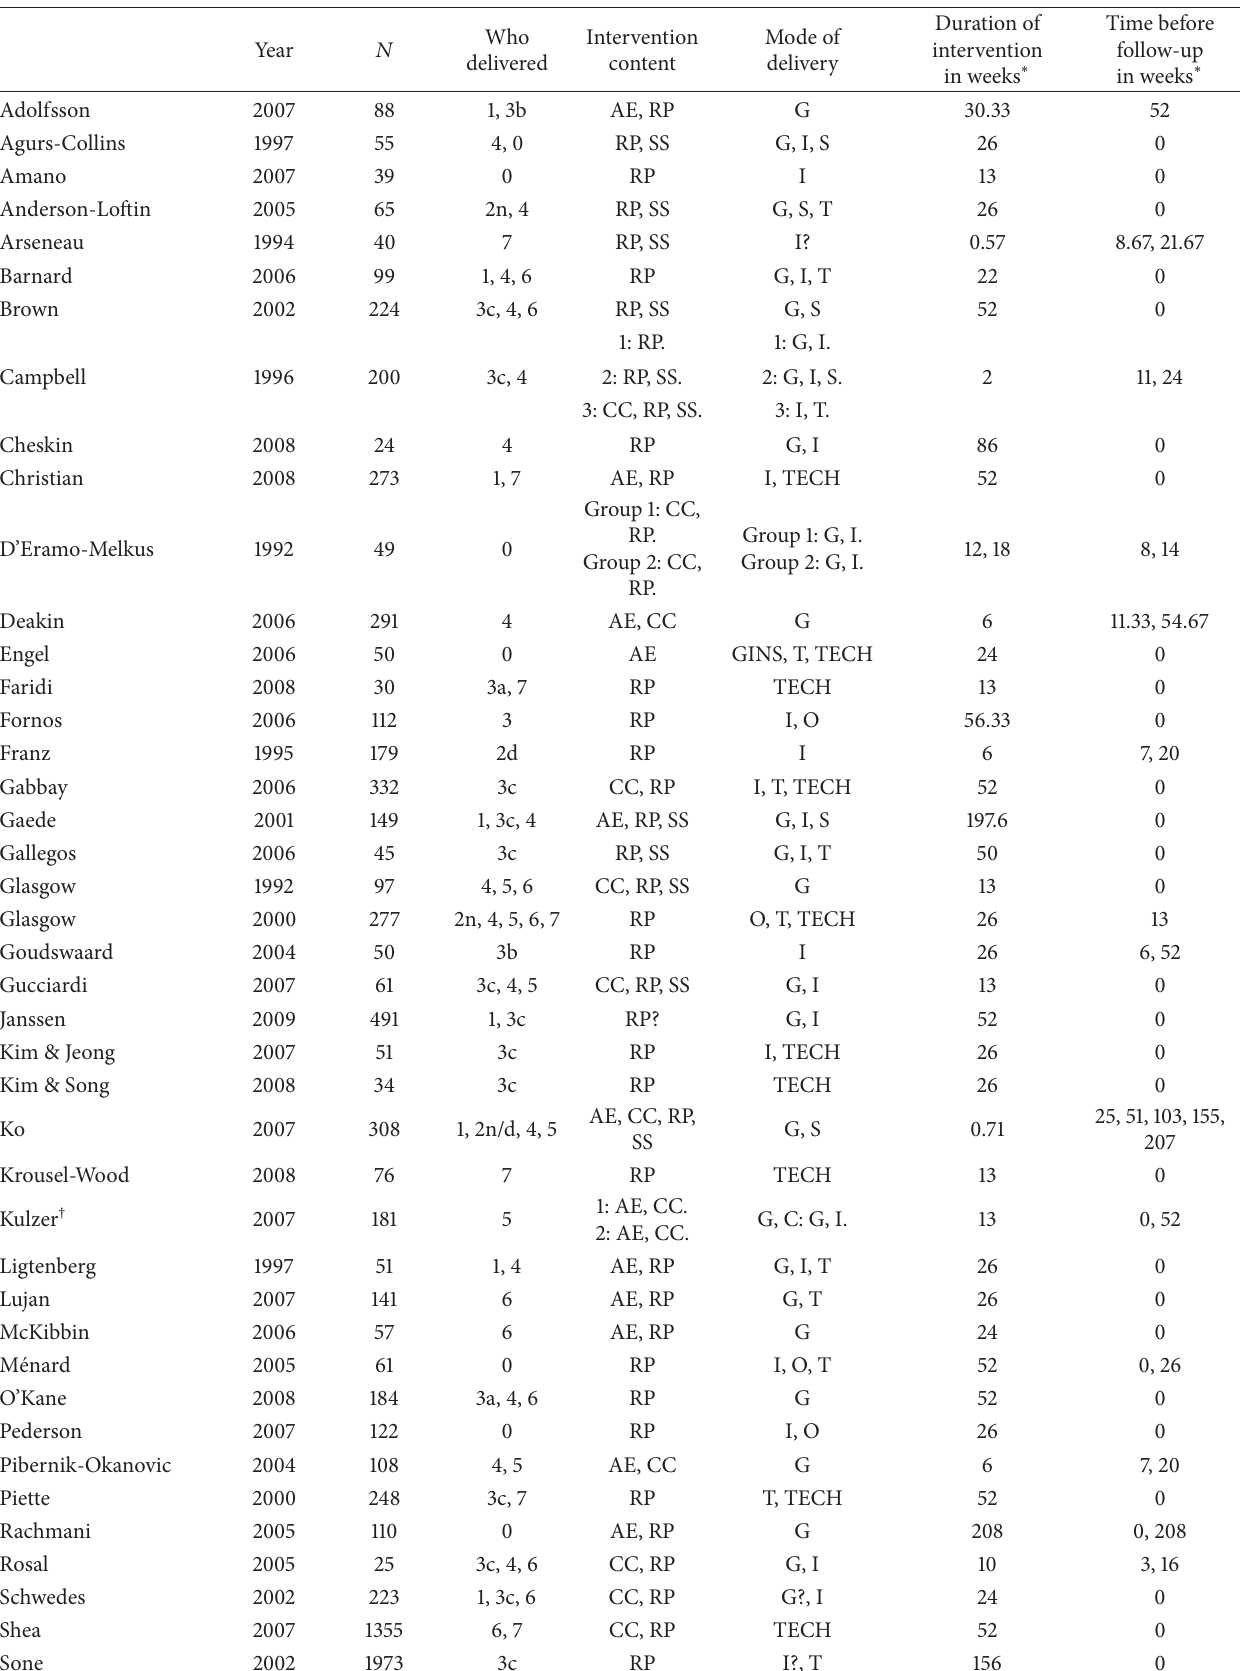
Table 1: Description of included studies and